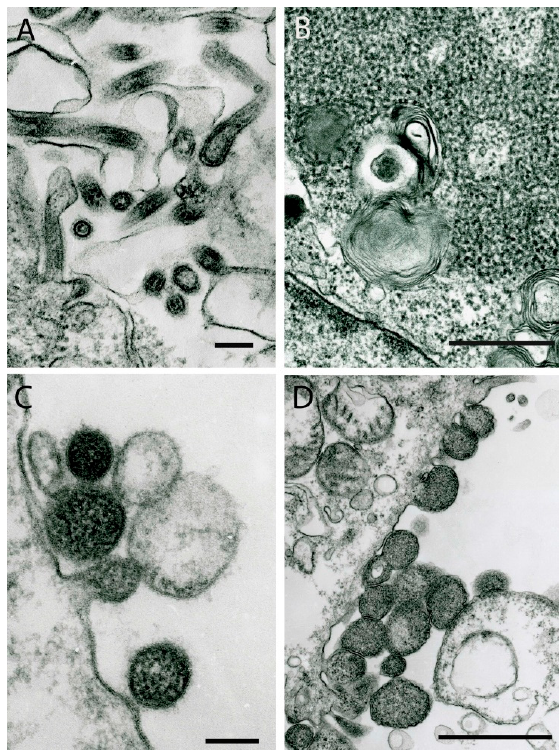
Figure 1. Ultrastructure of viruses of the order Mononegavirales . ( A ) JKT-2289 virus (unclassified; probable family Paramyxoviridae ): virions forming at the cell surface. Bar = 100 nm. ( B ) Cajazeiras virus (strain BeAn 447864) (unclassified; probable family Paramyxoviridae ): Cytoplasmic inclusion consisting of nucleocapsid nucleoproteins in Vero E6 cell, presented in strands 10–15 nm in diameter. Bar = 0.5 µ m. ( C ) Family Nyamiviridae : Nyamanini virus virions 100–160 nm in diameter forming at the cell surface. Bar = 100 nm. ( D ) Family Nyamiviridae : Sierra Nevada virus virions of variable sizes (300–750 nm in cross-section) forming at the surface of a Vero cell. Bar = 1 μ m.